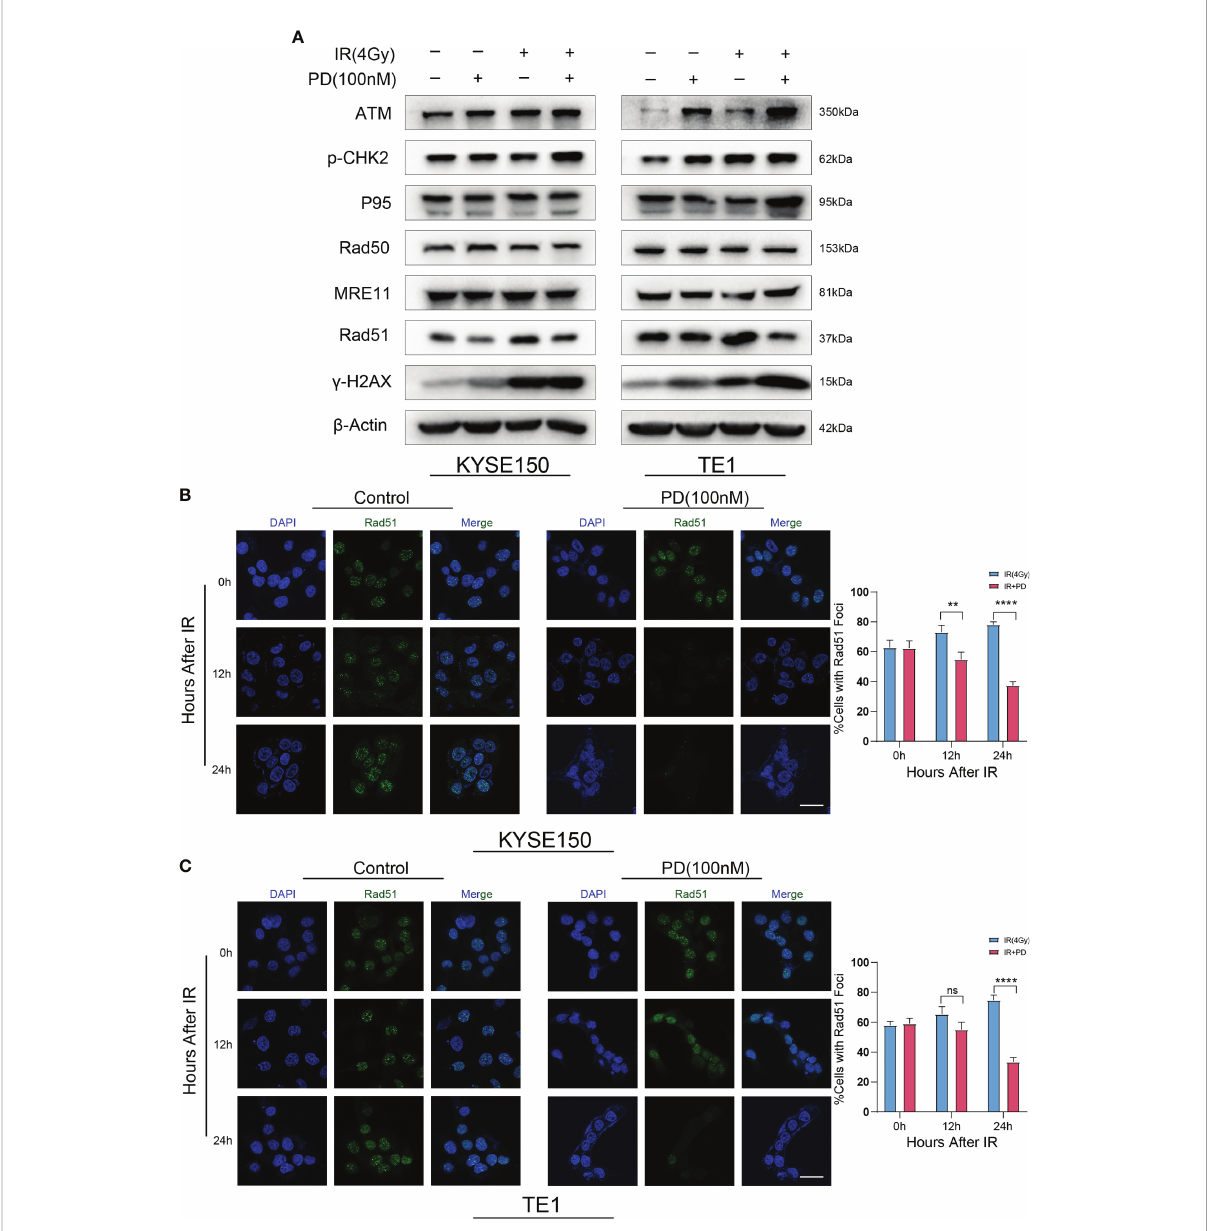
FIGURE 6 PD regulates DNA damage repair by Rad51. (A) DNA damage repair-related proteins are measured after irradiation, PD inhibits the expression of Rad51 in ESCC cells. (B) Rad51 foci is measured in ESCC cells at different time points with irradiation, combination therapy has few foci per nucleus. Scale bars: 20 m m (B, C) . **P < 0.01, ****P < 0.0001 , ns , no signi fi